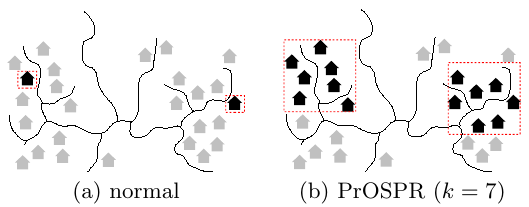
Figure 1: The different levels of information leakage using standard online route retrieval and our PrOSPR